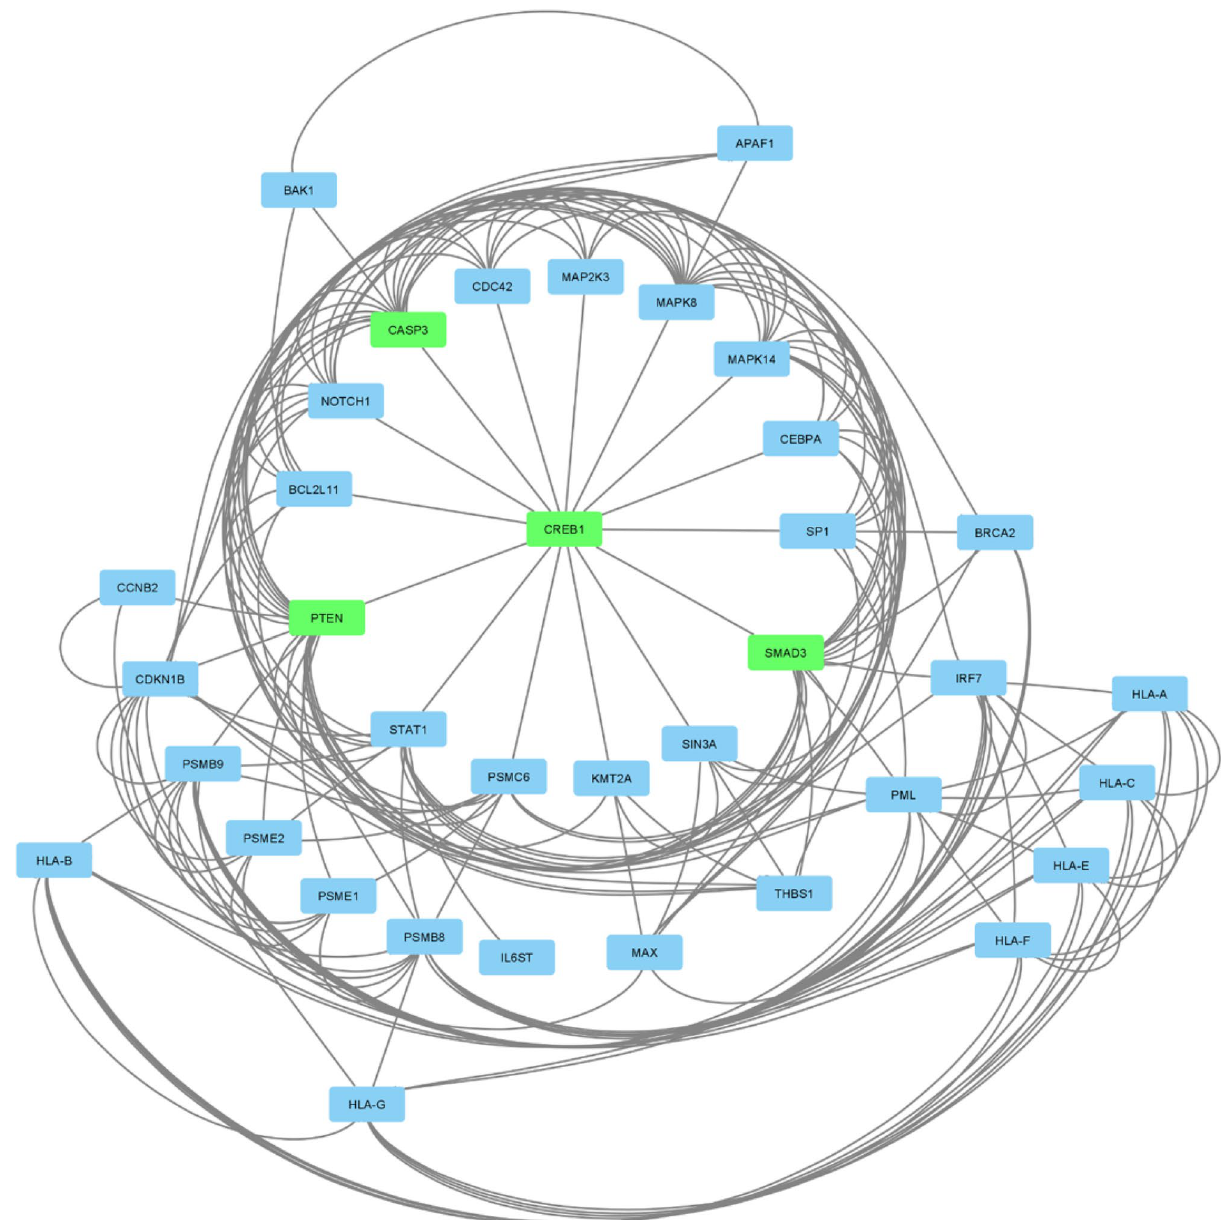
Figure 4. The Cytoscape network indicated hub genes. The yfile radial layout of Cytoscape software showed the most significant hub genes in cancer-related DEGs. The four important hub genes are shown in